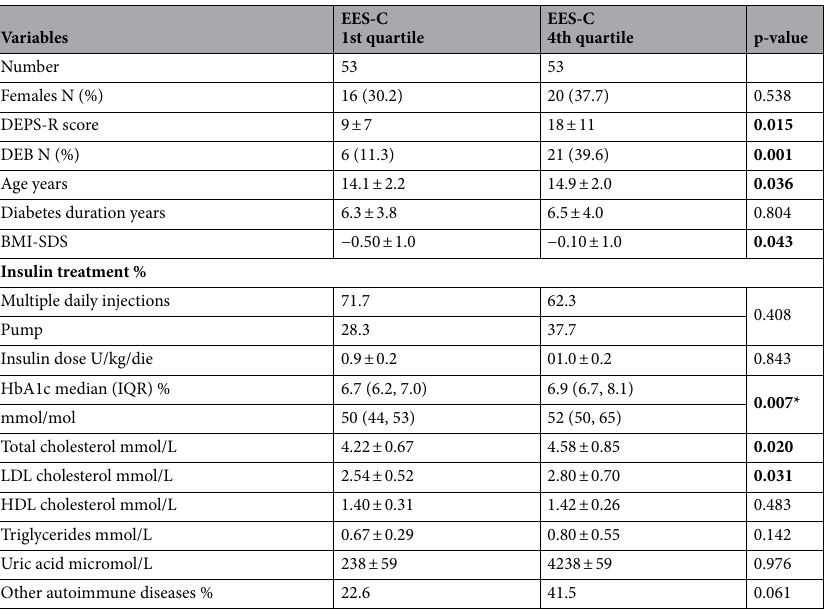
Table 2. Comparison between patients in the 1st (lower) quartile and 4th (higher) quartile of EES-C values. Data are presented as mean and standard deviation unless otherwise specified. For comparisons between groups two-tailed t-test was used. IQR inter quartile range, DEPS-R diabetes eating problem survey-revised, EES-C emotional eating scale for children and adolescents, DEB subjects with disordered eating behaviors (DEPS-R score ≥ 20), BMI-SDS body mass index-standard deviation score, HbA1c glycated hemoglobin, LDL low density lipoprotein, HDL high density lipoprotein. *Mann–Whitney test. Significant values are in